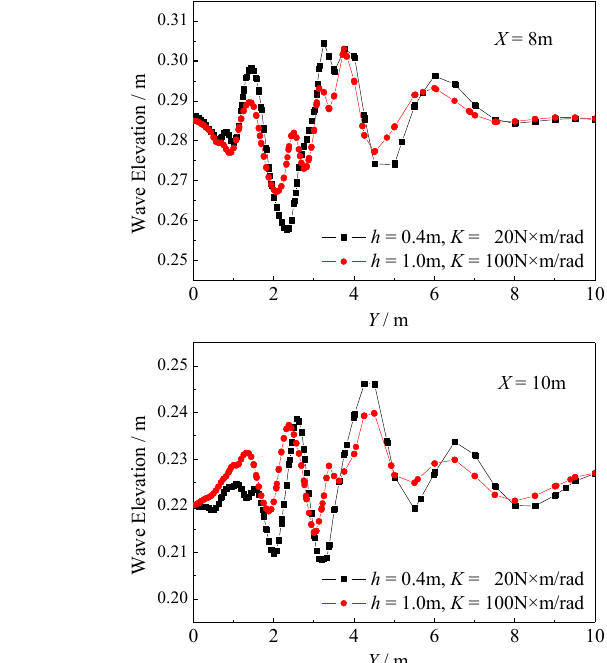
Figure 25. Distribution of wave heights along Y coordinate at four X coordinate positions in Figure 24.